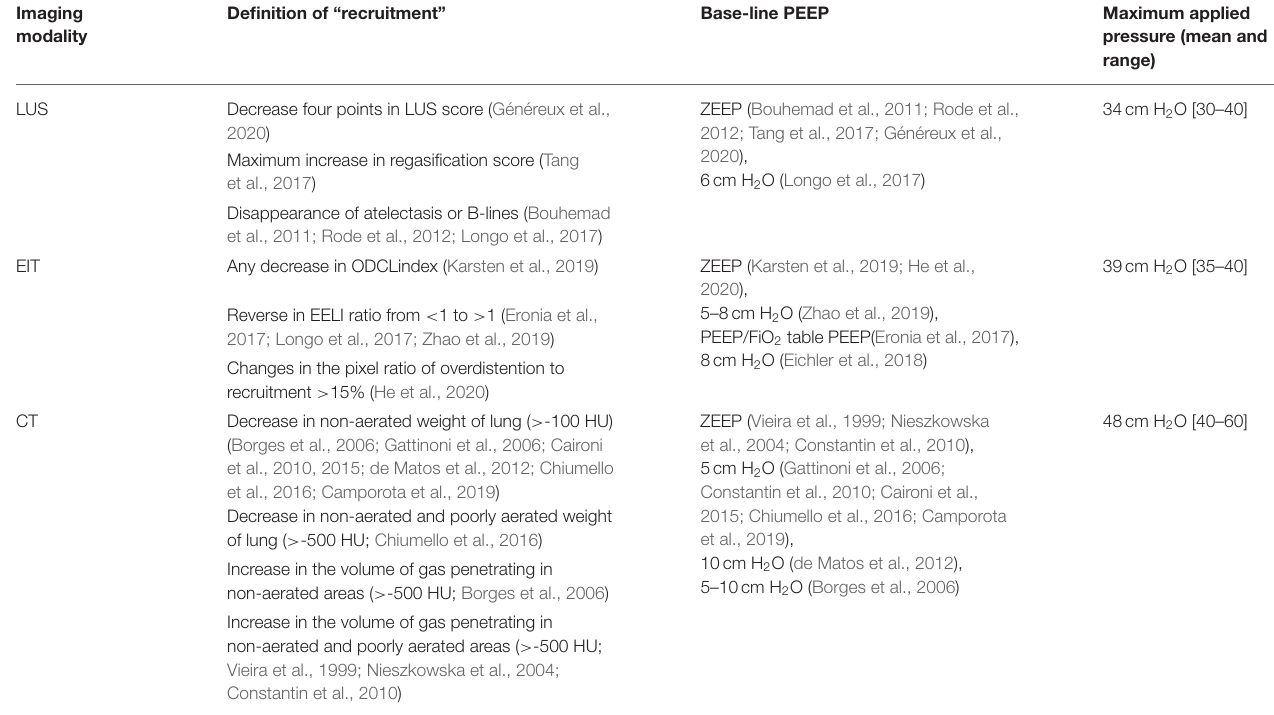
TABLE 2 | Findings related to the assessment of recruitment after recruitment maneuver application. Imaging